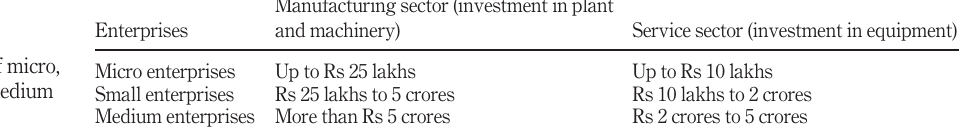
Table II. De fi nition of micro, small and medium